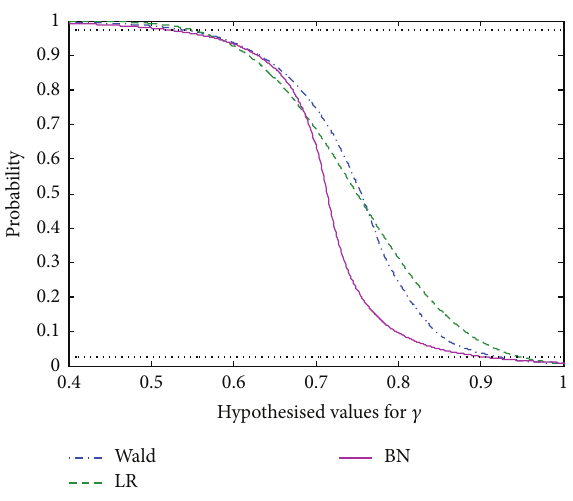
Figure 4: 𝑝 -value function for 𝛾 .